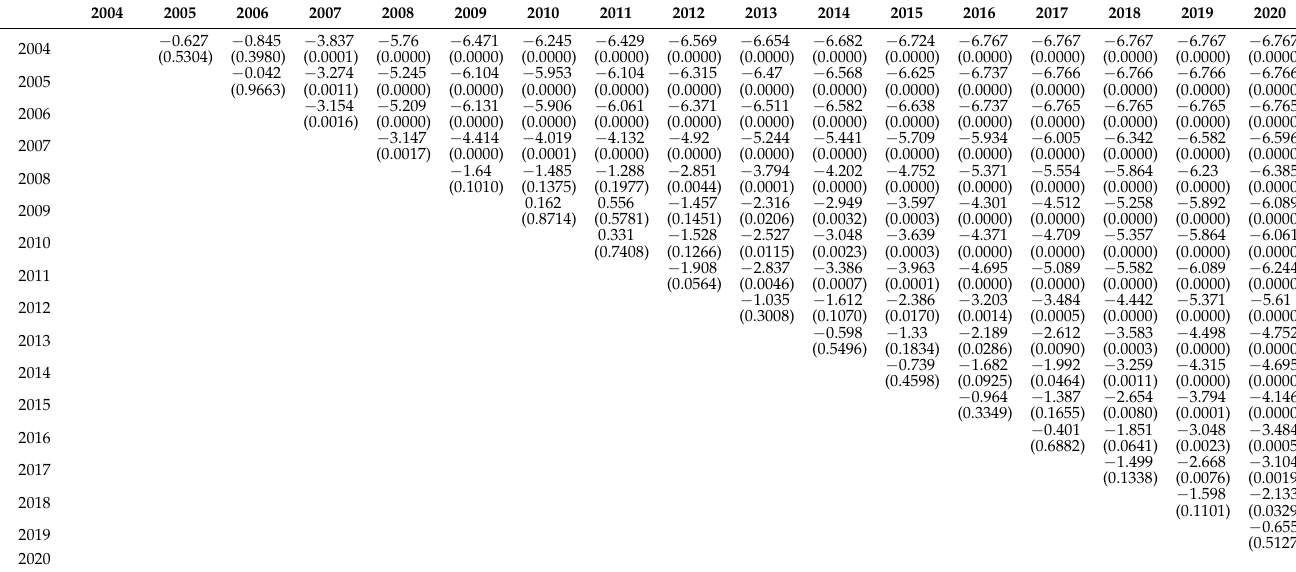
Table A2. The Increasing Rent Pattern behind: Mann–Whitney Test Basing on Indemnity